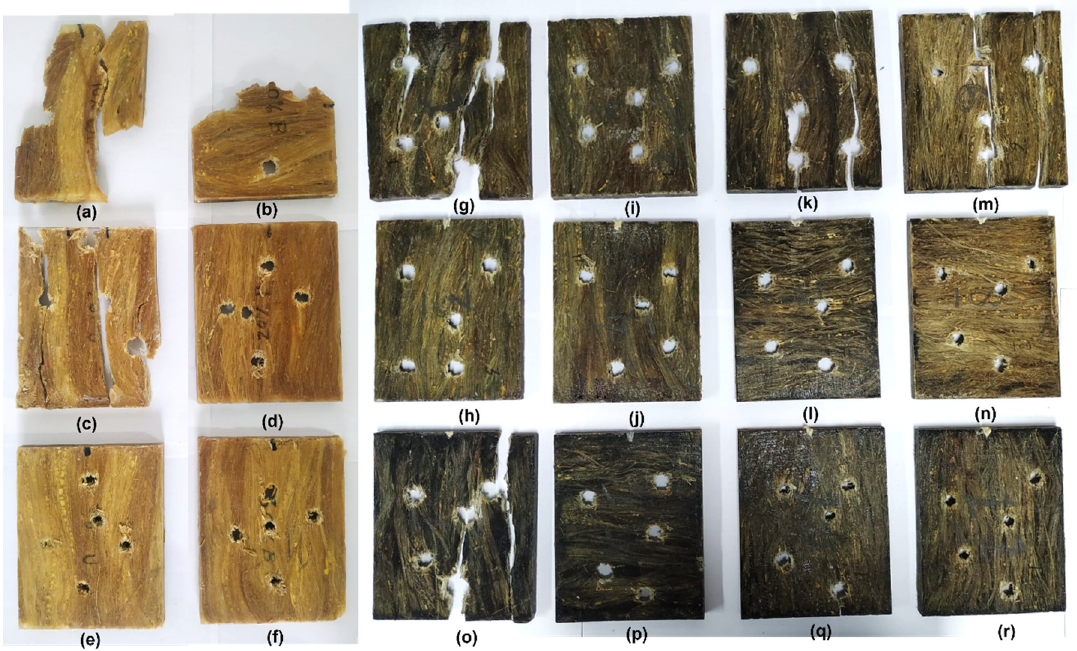
Figure 5. Aspect of the composite plates after ballistic test for each group: 10UD ( a ), 10BD ( b ), 20UD ( c ), 20BD ( d ), 30UD ( e ), 30BD ( f ) for PNT/ENT; 20UD ( g ), 20BD ( h ), 30UD ( i ), 30BD ( j ) for PGO/ENT; 20UD ( k ), 20BD ( l ), 30UD ( m ), 30BD ( n ) for PNT/EGO; and 20UD ( o ), 20BD ( p ), 30UD ( q ), 30BD ( r ) for PGO/EGO.